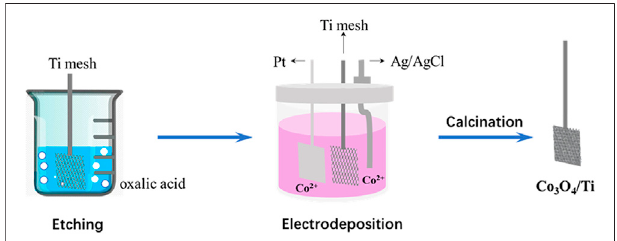
FIGURE 1 | Schematic of the preparation